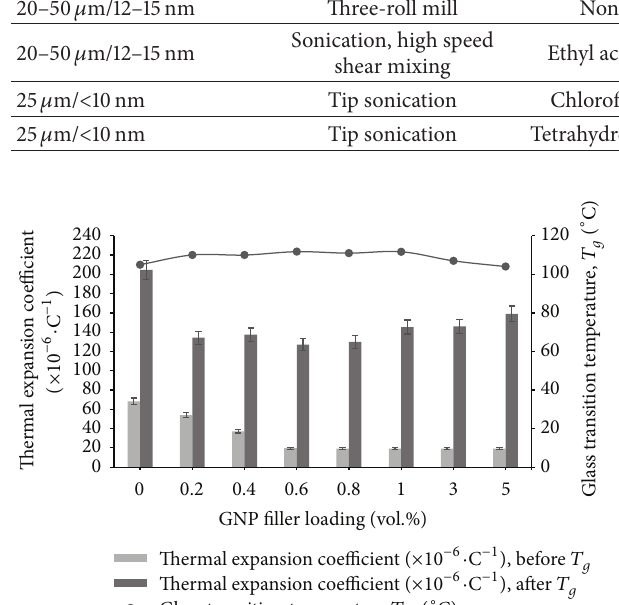
Figure 7: Thermal expansion coefficient of GNP filled epoxy